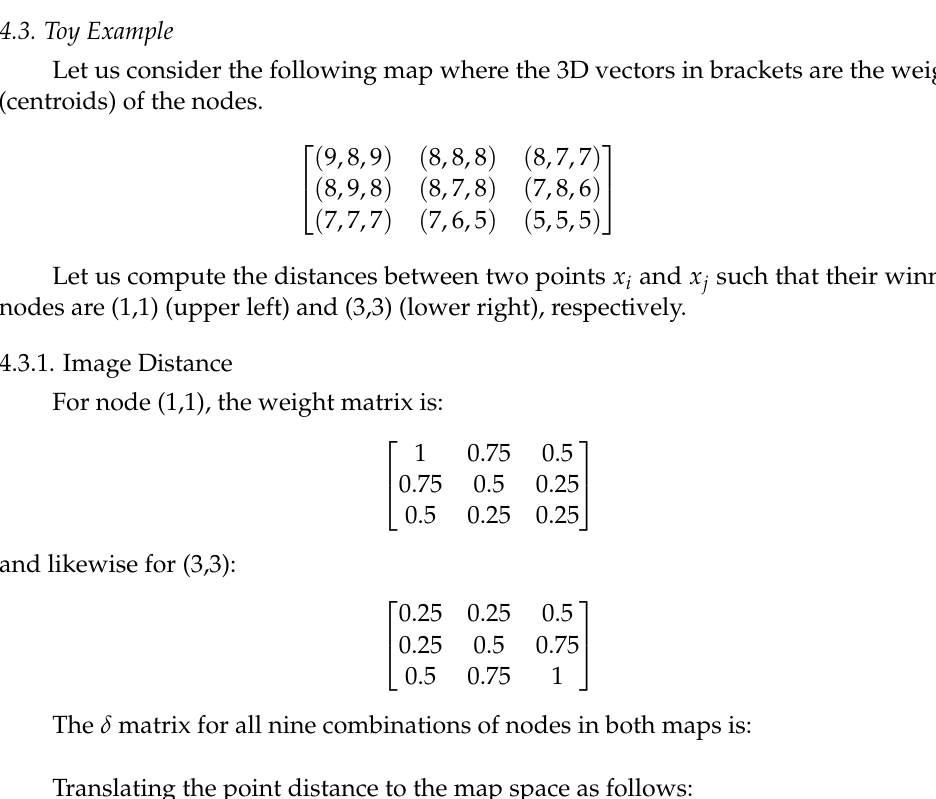
Figure 5. Graph distance. In this case, the distance comes from considering our map as a graph where the nodes are the nodes of the map and the edges represent the chosen neighborhood. The distance between winning nodes, representing the points in the new space, will be the minimum path in that graph, in this case, represented with the nodes and edges in